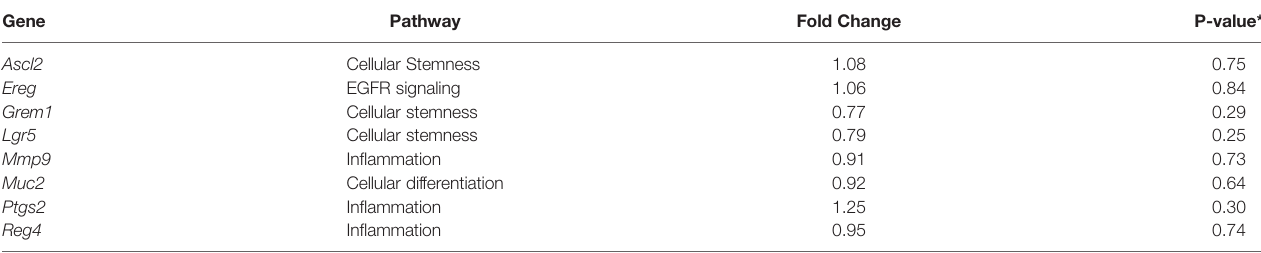
TABLE 4 | Mean fold change in gene transcription in the initiated colonic mucosa of tumor-bearing vs tumor-free Apc +/Min-FCCC mice after removing outliers. Gene Pathway